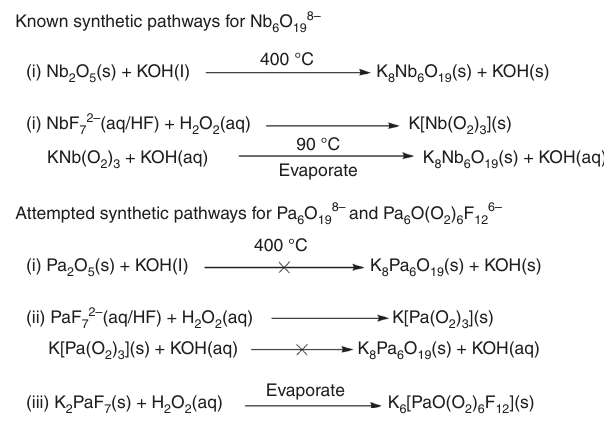
Fig. 2 Reaction pathways to produce polyoxometalates. The known reactions for the synthesis of polyoxometalates are presented along with